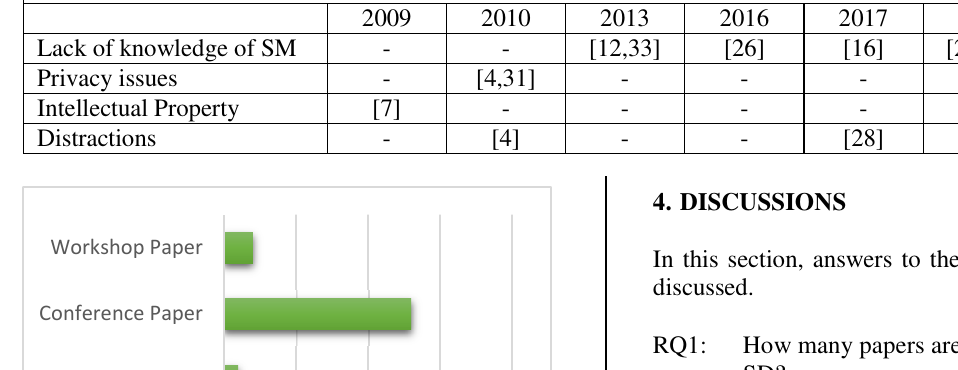
TABLE 4. REFERENCES FOR LIMITATIONS OF USING SM ACCORDING TO THE SELECTED